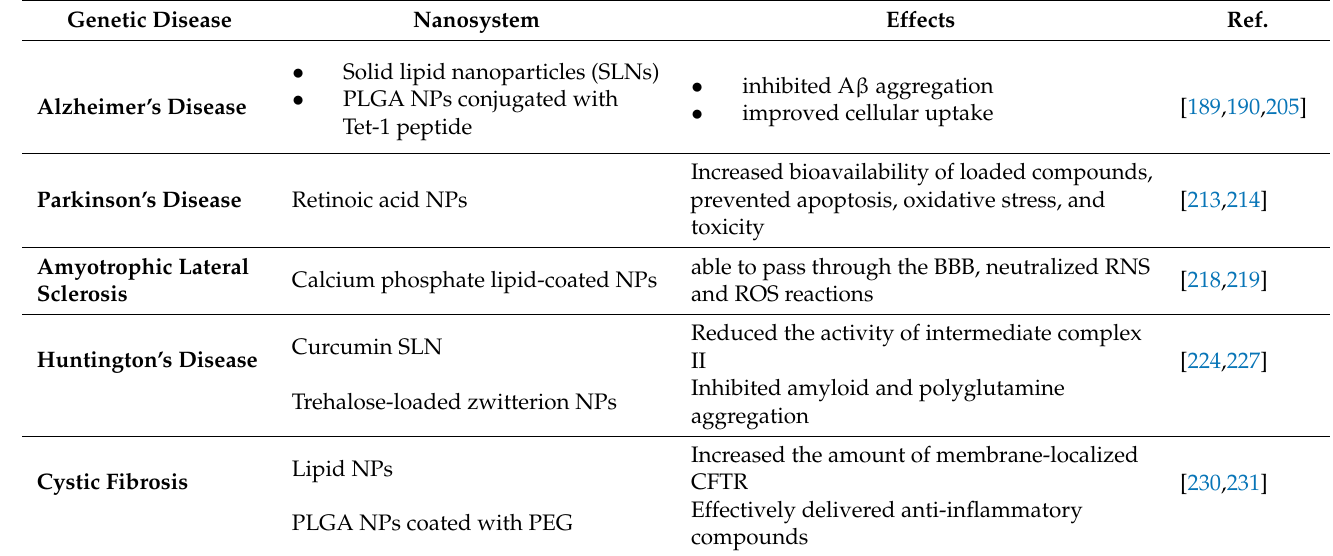
Table 2. Summary of the various nanosystems used for treating genetic disorders. Genetic Disease Nanosystem Effects